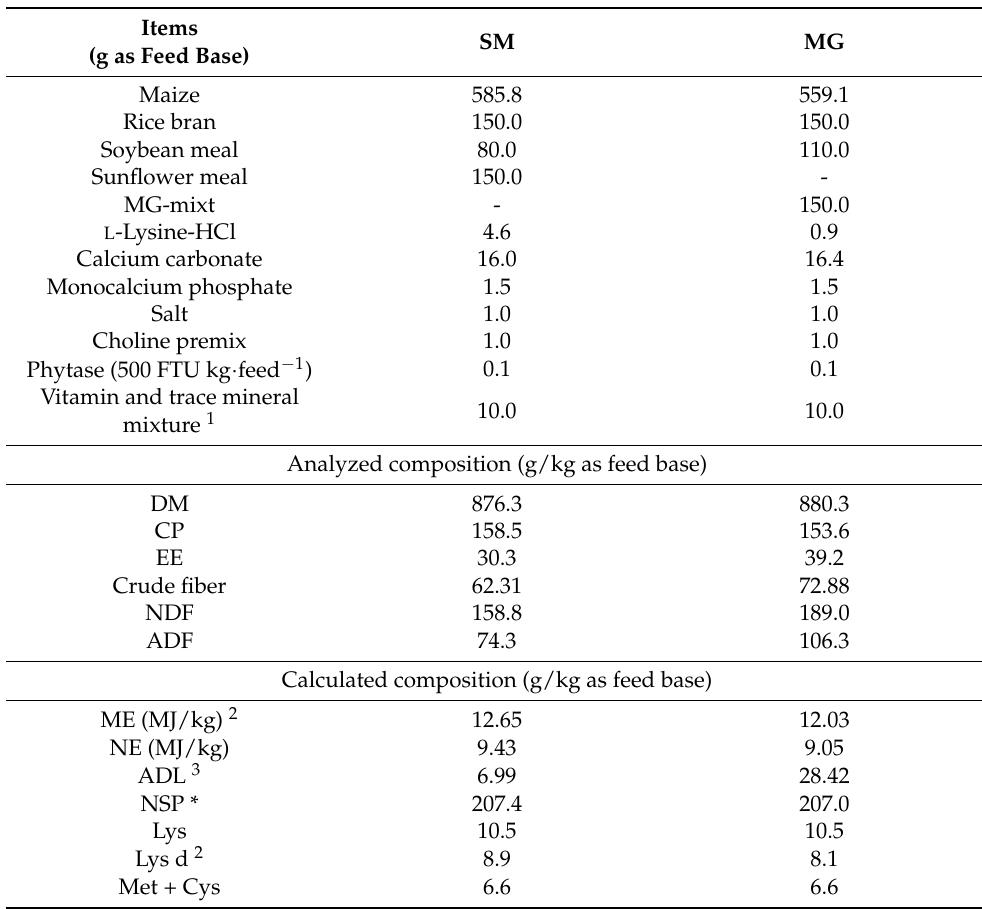
Table 1. Diet composition for Topigs hybrid pigs fed a standard level of fiber (SM diet) or a diet based on a high level of fiber (MG